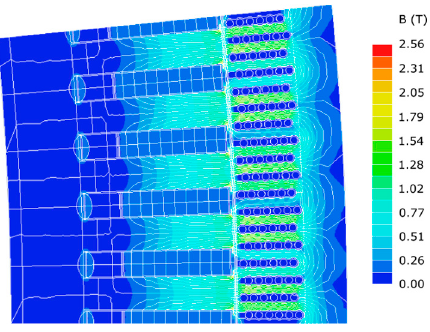
Figure 8. Magnetic field lines in the LG for Case 8, where 75% of the PM is Y40 and 25% is Y30 and the pole shoe is T-shaped and shortened to 90% of its initial value.